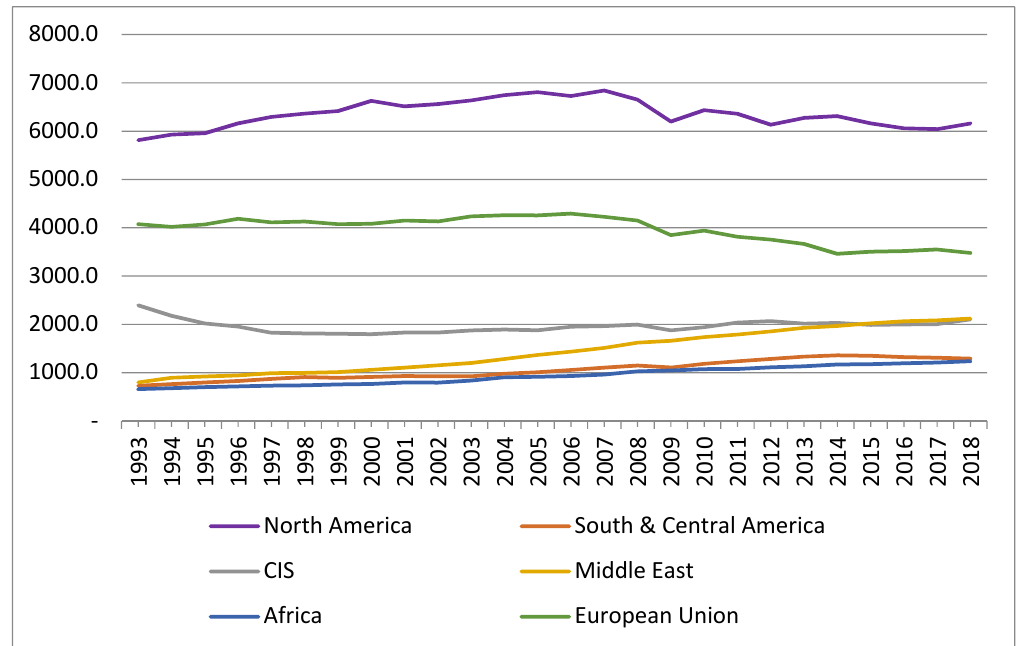
ff erent regions, 1993–2018, million tons of carbon dioxide Figure 2. CO 2 emissions in different regions, 1993–2018, million tons of carbon dioxide, [4]. 68 Figure 2. CO 2 emissions in di